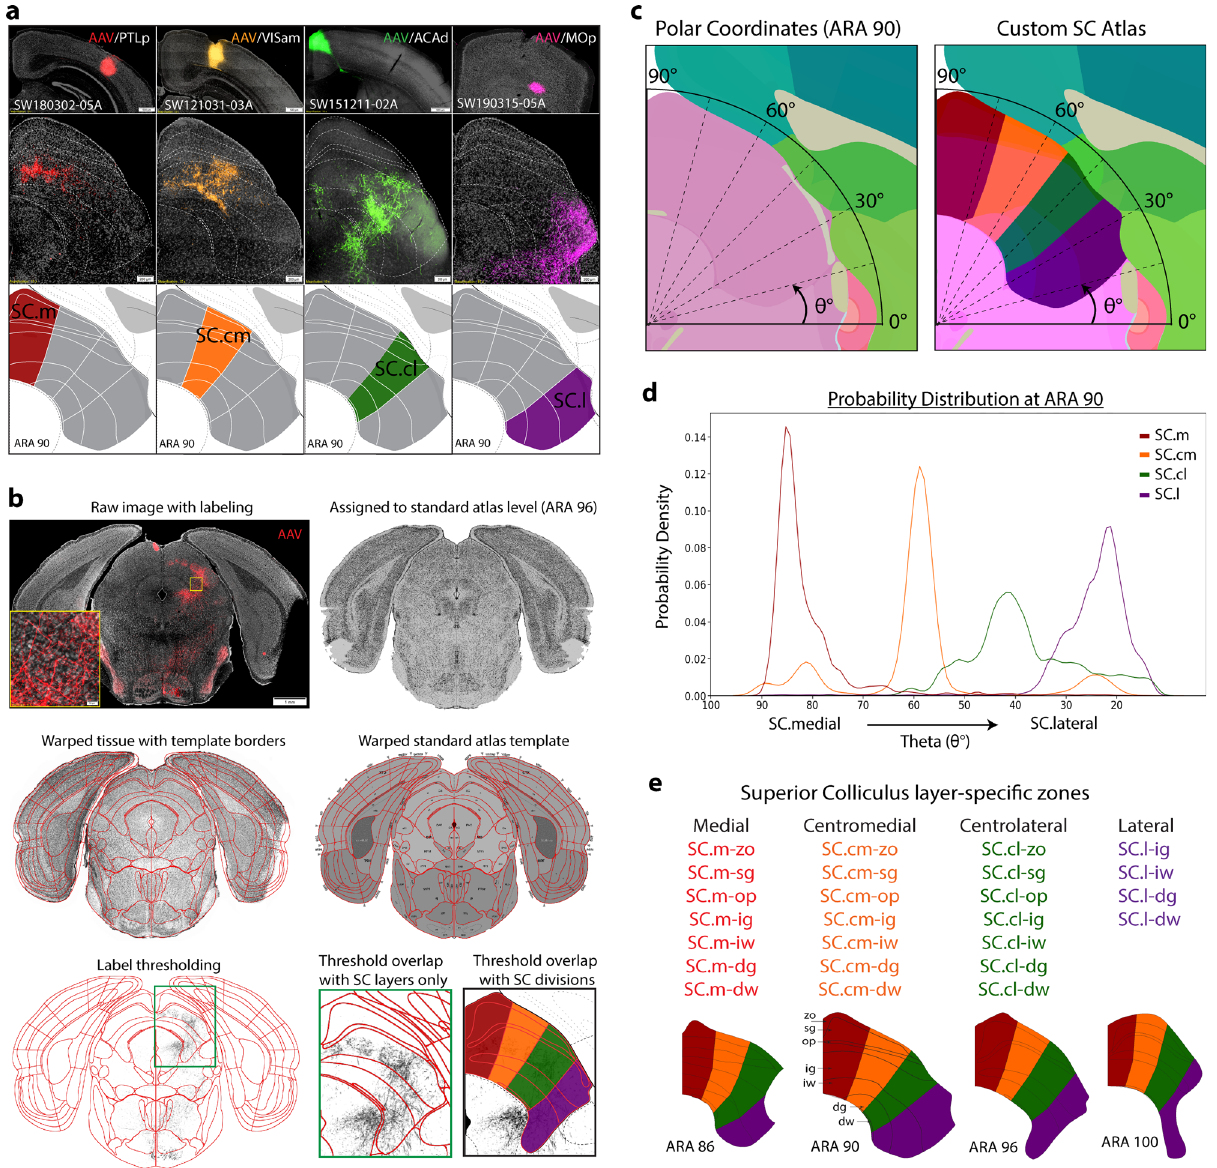
Fig. 1 Experimental work fl ow. a Raw data examples of cortico-tectal projections targeting distinct zones within SC layers at ARA 90. Anterograde AAV injections into PTLp → SC.m (red), VISam → SC.cm (orange), ACAd → SC.cl (green), and MOp → SC.l (purple) terminate with different laminar and nonoverlapping patterns. Together, these representative cortico-tectal projections reveal layer-speci fi c terminals distributed across four distinct zones along the medial-lateral axis of SC. Scale bar at injection sites is 500 µ m, and 200 µ m in lower SC panels. b The Connection Lens neuroinformatics work fl ow: Raw tissue image with anterograde labeling is assigned to the corresponding standard atlas level (this example is ARA 96). The tissue is warped based on template atlas borders and reconstructed using in-house neuroinformatics software. Thresholded images are overlapped onto a custom atlas for zone- and layer-speci fi c registration for pixel quanti fi cation. c Left: Polar Coordinate analysis method used to quantify angular distribution of thresholded pixel labeling in SC. Angles represented by theta ( θ °) values where midline starts at 90° and ranges toward 0° at lateral angles. Right: Custom SC atlas with overlay of angular range shows coarse alignment of manually delineated borders in SC. d Example of probability distribution graph for average distributions of zone-speci fi c cortico-tectal cases. Peaks are aligned with custom SC borders at ARA 90. SC.m (red) is SW180522-04A. SC.cm (orange) is SW121221-03A. SC.cl (green) is SW171130-02A. SC.l (purple) is SW170410-04A. e Layer- and zone-speci fi c SC nomenclature to facilitate referencing and quanti fi cation. Below: zone delineations across representative ARA levels (86, 90, 96, 100) spanning rostral-to-caudal SC. ACAd anterior cingulate cortex dorsal part, ARA Allen reference atlas, AAV Adeno-associated virus, PHAL Phaseolus vulgaris leucoagglutinin, PTLp posterior parietal cortex, MOp primary motor cortex, VISam visual cortex anterior medial part, SC superior colliculus, SC Layers: zo zonal, sg super fi cial gray, op optic, ig intermediate gray, iw intermediate white, dg deep gray, dw deep white.